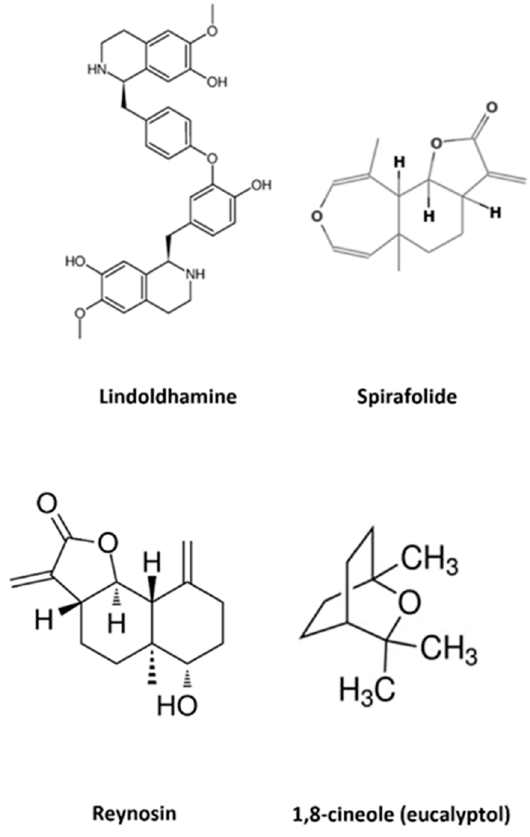
Figure 3. Chemical structures of specific bioactive components of Laurus nobilis.